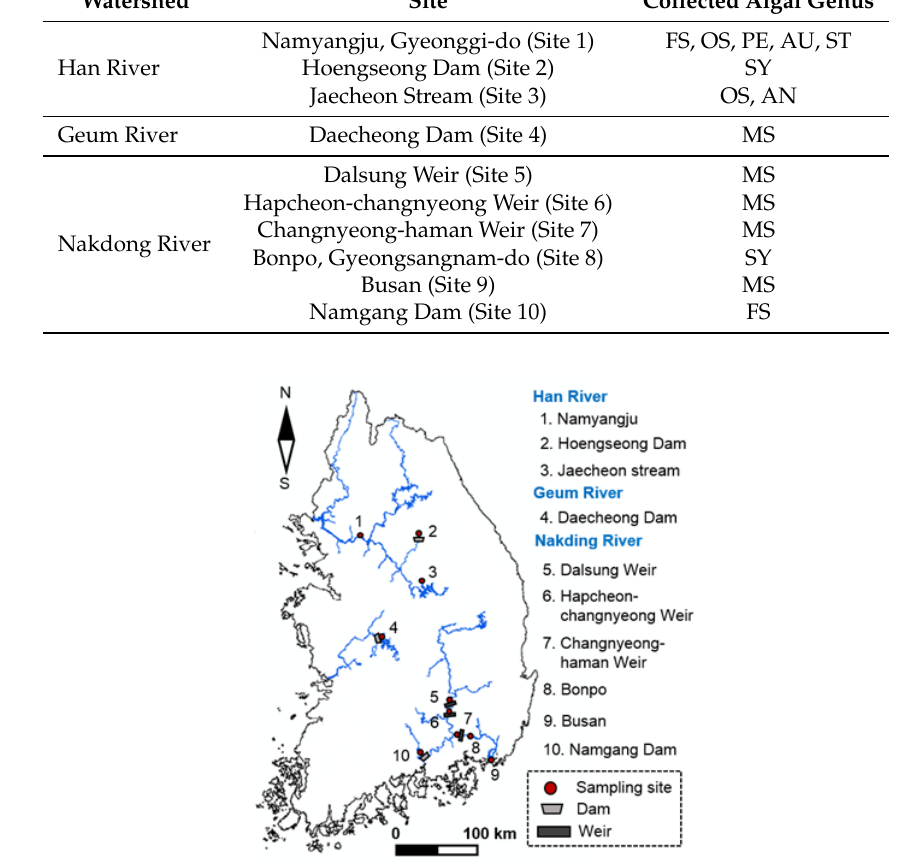
Figure 7. Algal species sampling sites in South Korea for CNN model